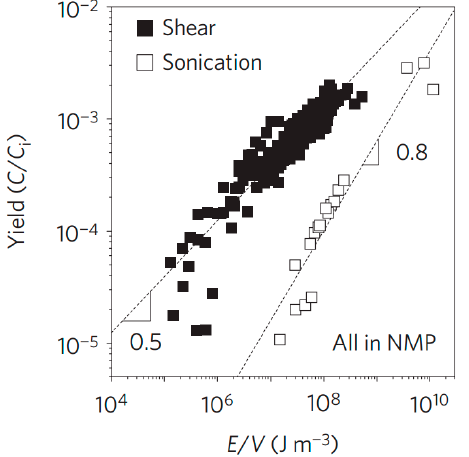
Figure 8. Graphene yield measured versus energy density. Reproduced from [19]. Copyright Nature Publishing Group, 2014.